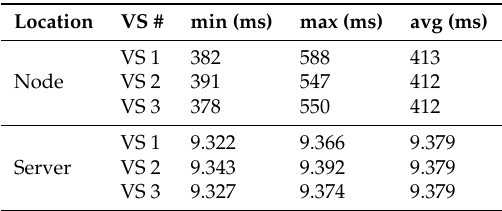
Table 4. Virtual sensor time to